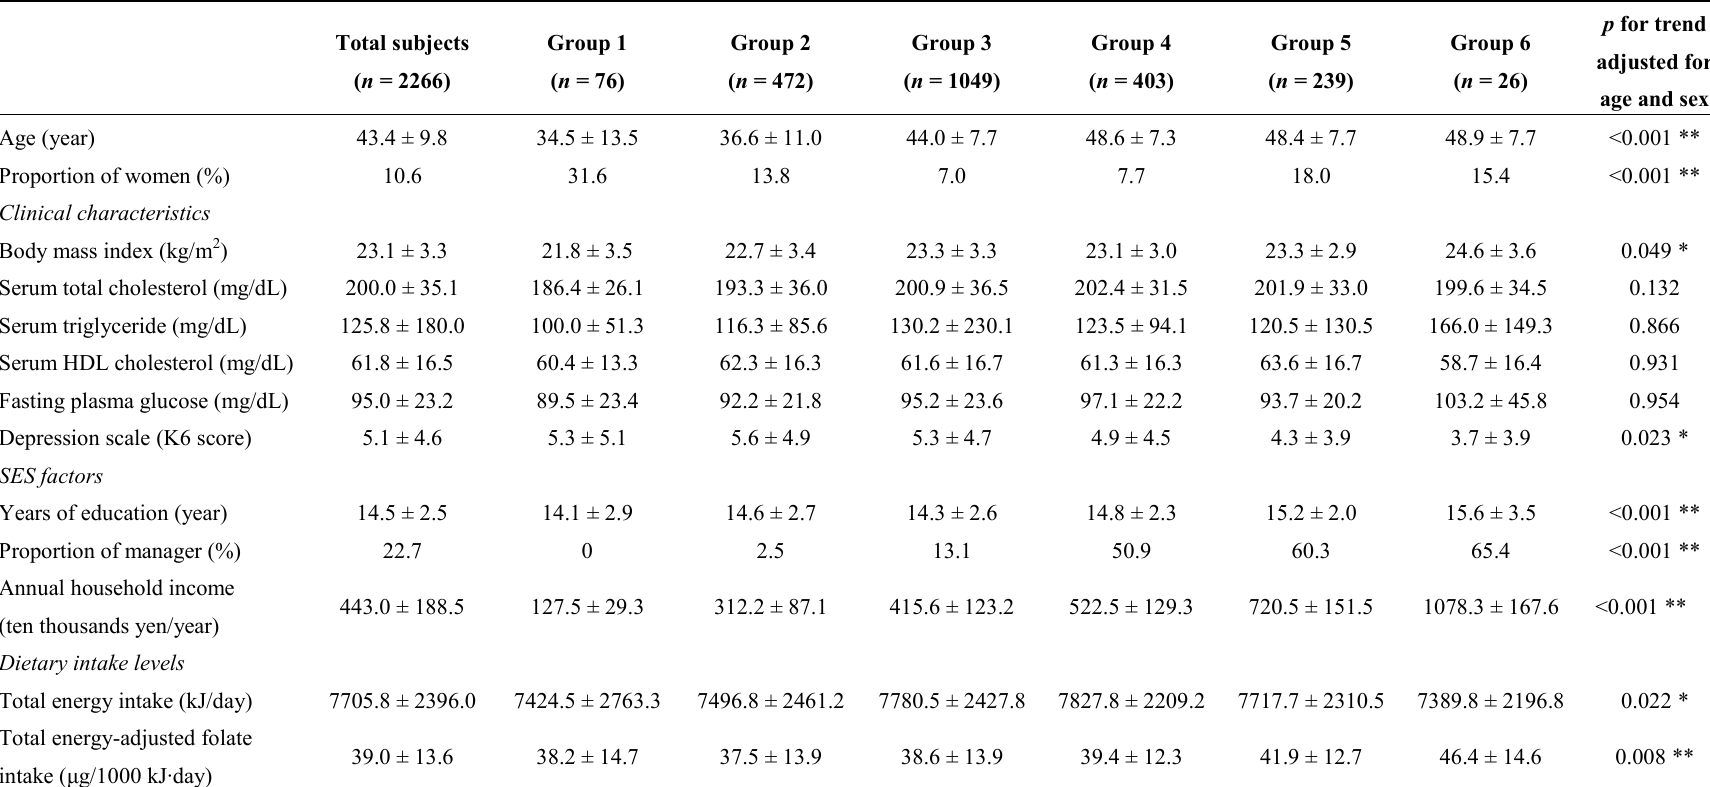
Table 2. Clinical characteristics, dietary nutrients intake data, and socioeconomical status factors of the study subjects according to different household income